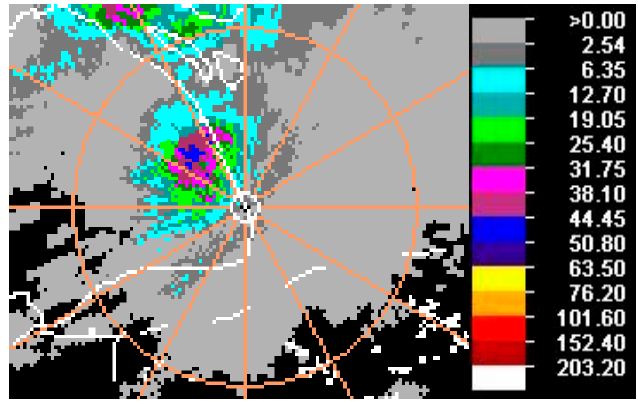
Figure 1. Radar image for 1 h cumulative rainfall at 9:12 CST (25 August 2008) (the unit of the color bar is mm).